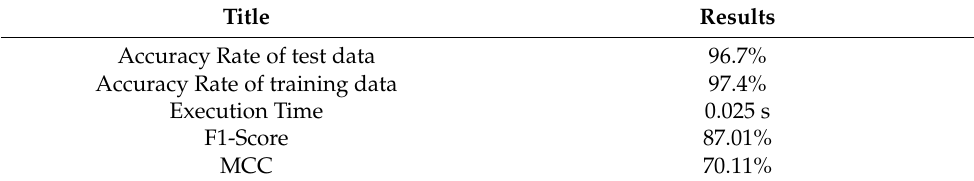
Table 5. Artificial Neural Network Classifier Outcome.